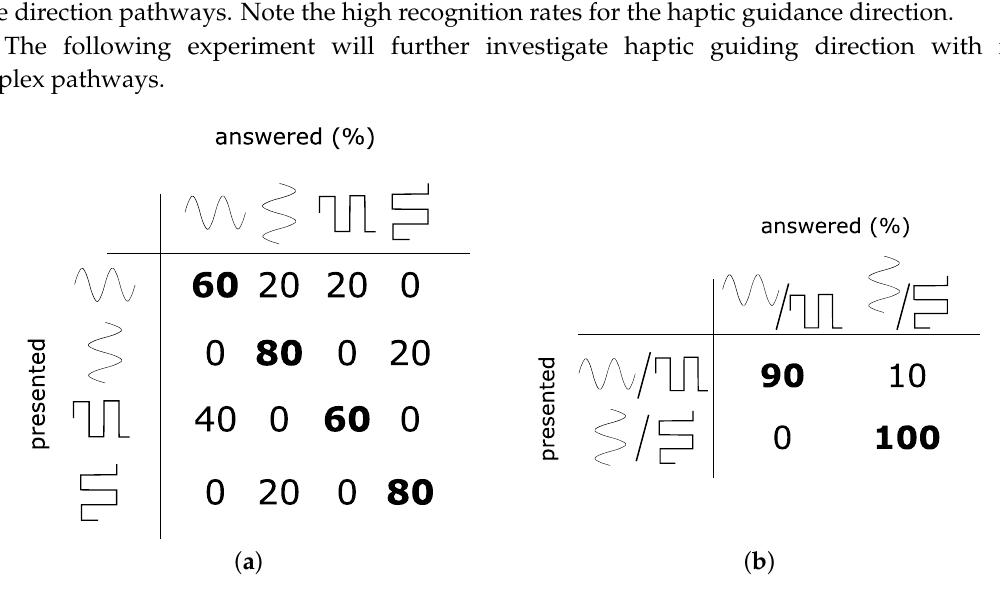
Figure 7. Confusion matrices for the simple pathway recognition experiment: ( a ) pathways considered individually and ( b ) pathways grouped by